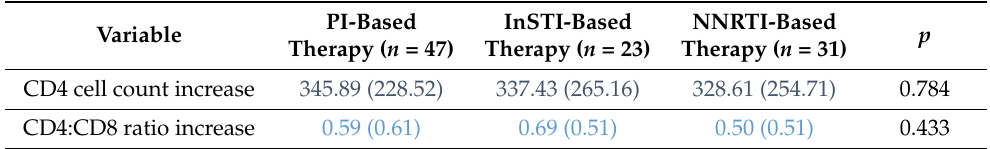
Table 6. CD4 cell count and CD4:CD8 recovery depending on the applied ART regimen.